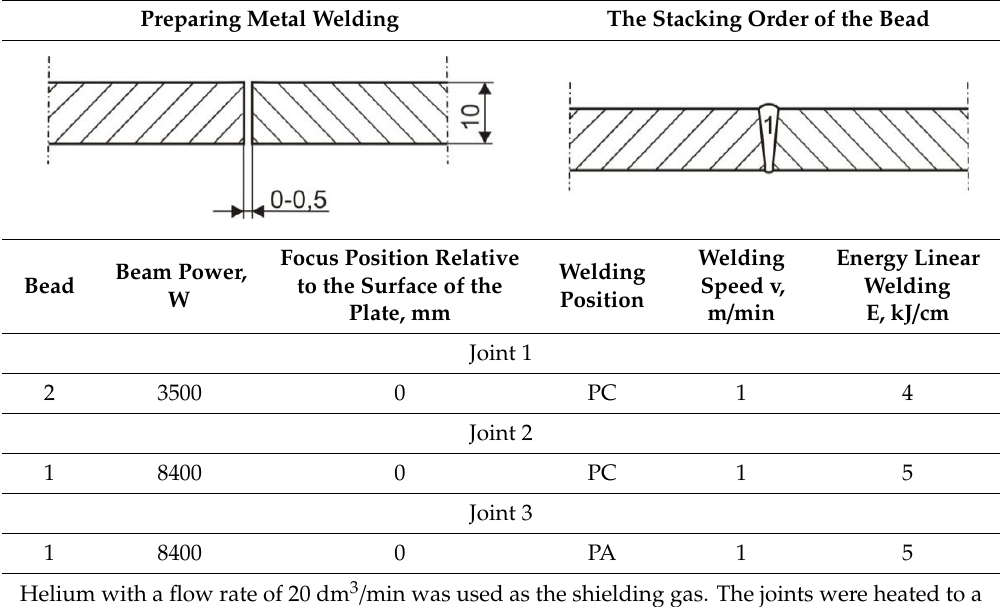
Table 3. Parameters welding S700MC a thickness of 10 mm with a laser beam.